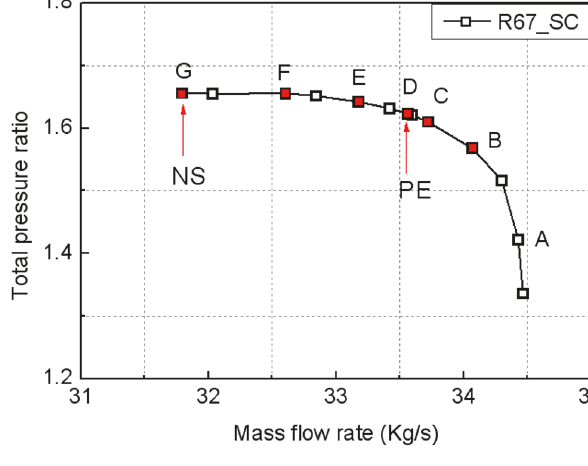
Table 2: 𝑍 𝑏𝑝 in bell-shaped curves and the experimental SMI